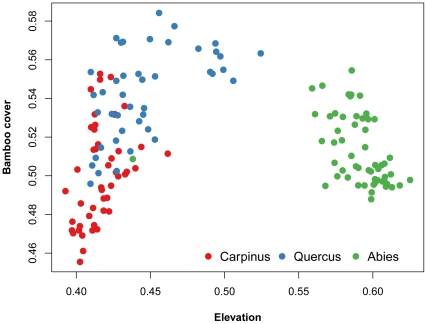
Multidimensional fuzzy set ordination diagram of forest vegetation plots from Halla Volcano, South Korea.The first axis represents a fuzzy elevation gradient from low elevation on the left to high elevation on the right. The second axis represents a fuzzy gradient from plots with low dwarf bamboo (Sasa quelpaertensis) cover on the bottom to plots with high bamboo cover on the top. Colors represent the three main forest vegetation types named after the dominant tree species.